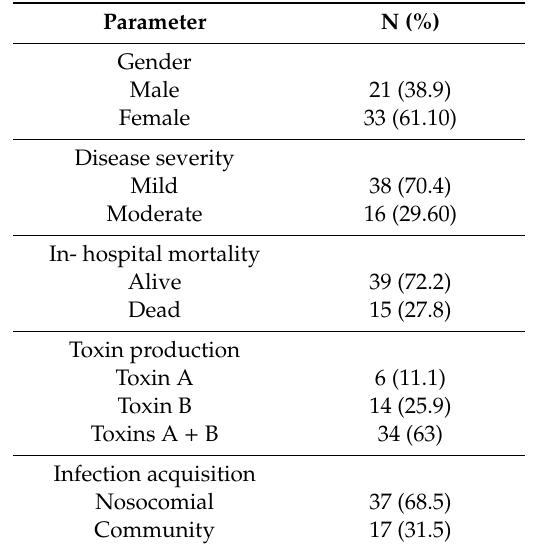
Table 1. Clinical and demographic characteristics of patients with Clostridioides di ffi cile infection (CDI).